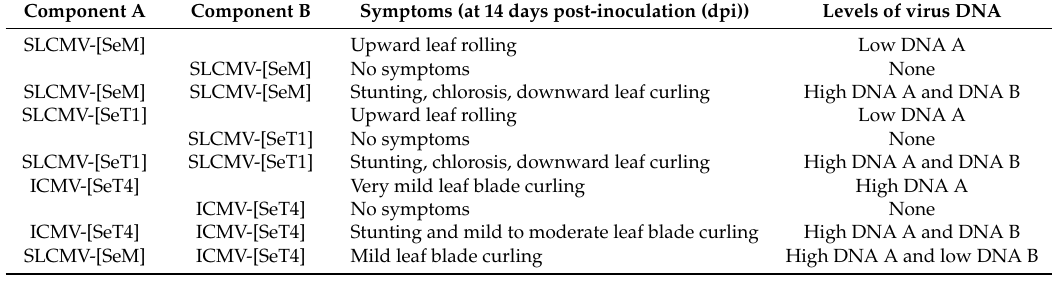
Table 2. Infectivity analysis by agroinoculation of SLCMV-[SeM], SLCMV-[SeT1] and ICMV-[SeT4] partial dimers in Nicotiana benthamiana plants.